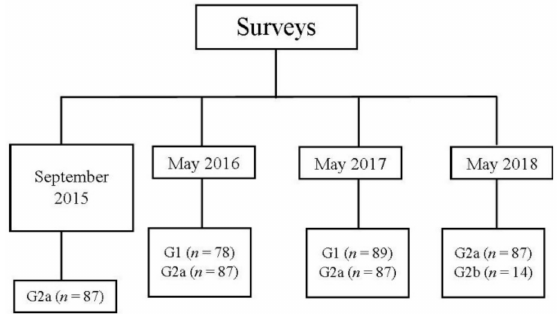
Figure 3. Data survey collection process.